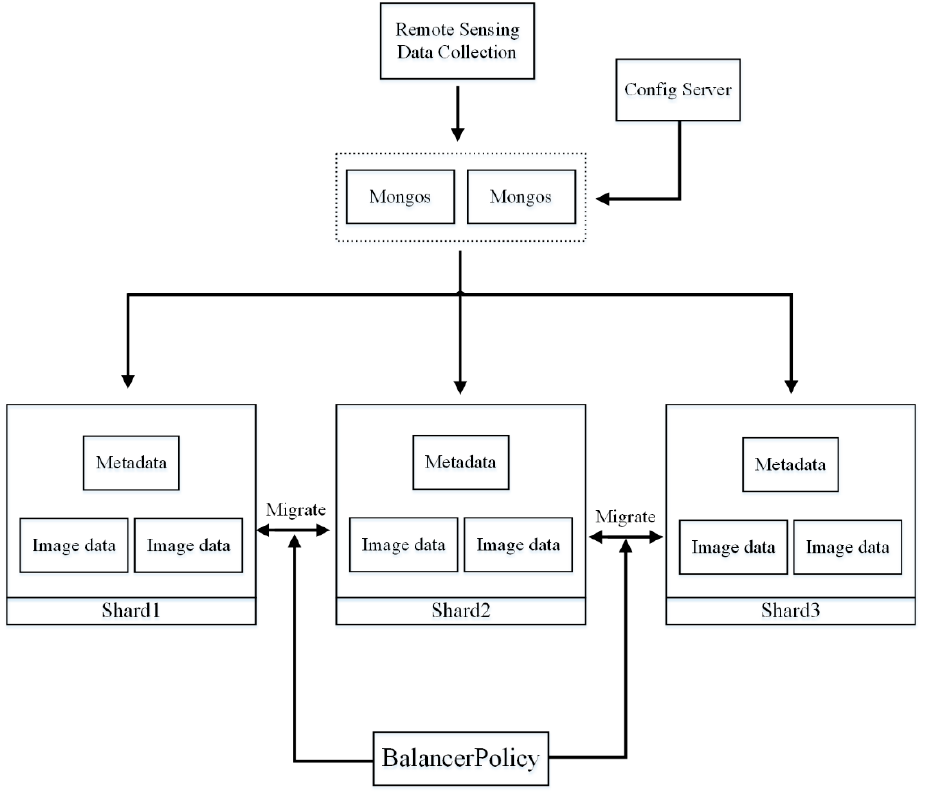
Figure 6. Storage workflow in the distributed environment.